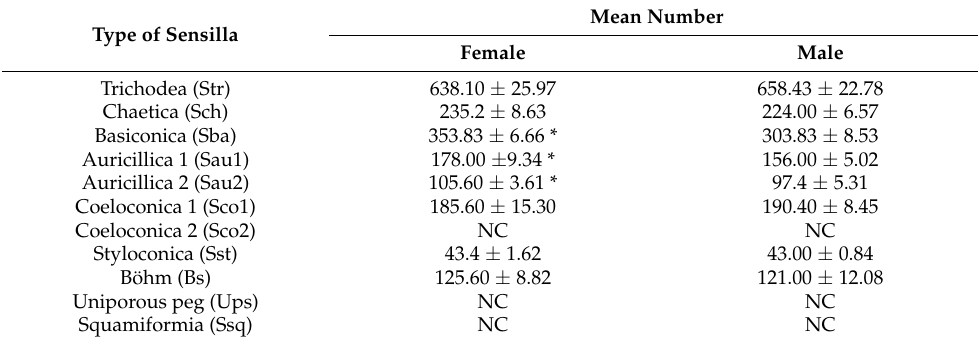
Table 2. Estimated number of sensilla in the antennae of male and female of T. rufivena